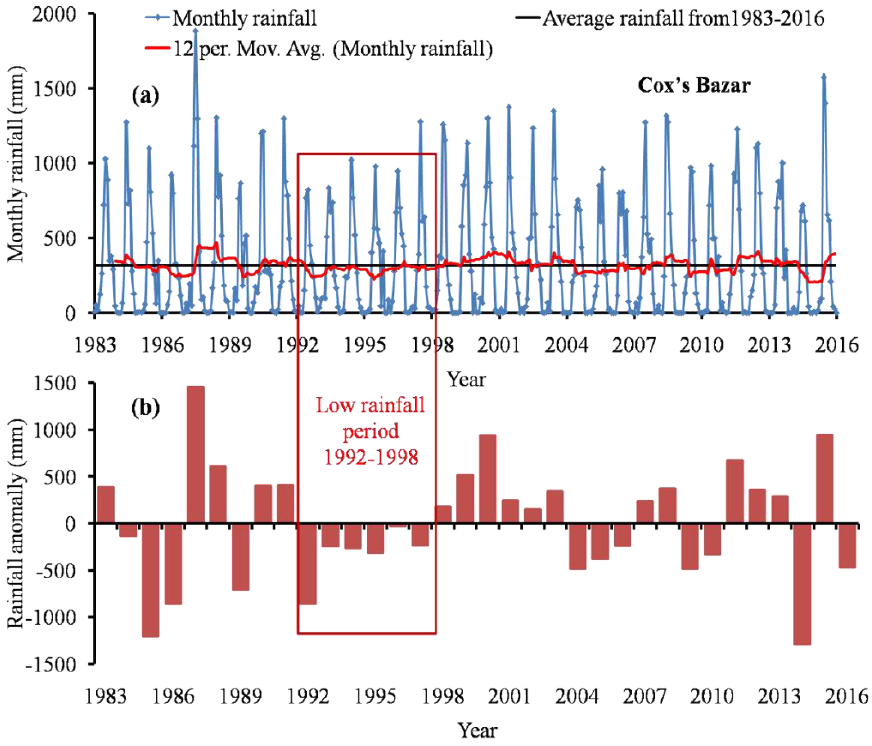
Figure 13. ( a ) Time-series rainfall data of the Cox’s Bazar station. ( b ) Rainfall anomaly from 1983–2016. Anomaly represents the fluctuation of the yearly rainfall from the zero mean.